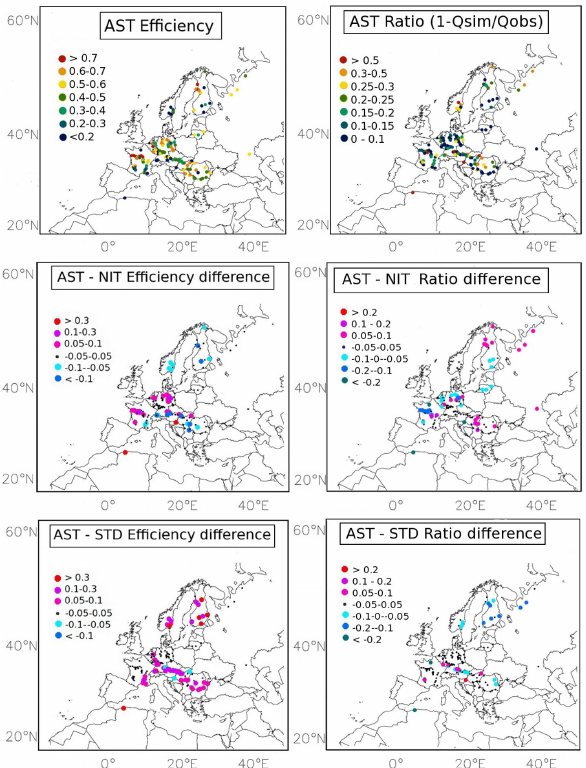
Fig. 6. Comparison between (top panel) AST-TRIP and observed GRDC river discharges in terms of (left panel) Eff scores and (right panel) | 1 − Q sim Q obs | values for the 150 gauging stations of the CNF area, and (middle panel) differences between AST and NIT scores and (bottom panel) AST and STD scores. Positive differ- ence values correspond to (left panel) better and (right panel) poorer scores. The scores are based on daily values over the 1991–2008 pe-